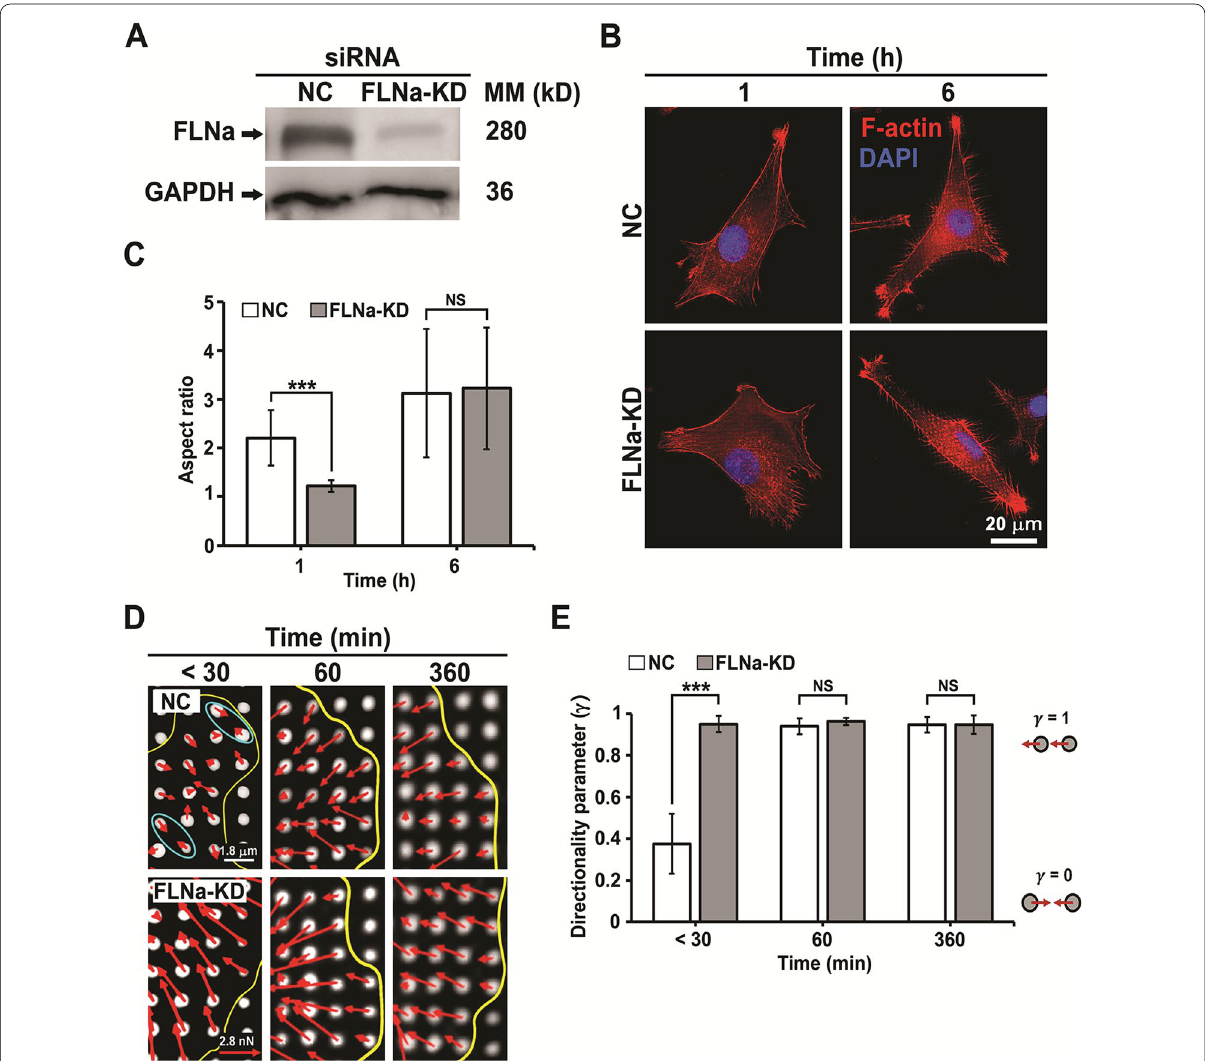
Fig. 2 Cell spreading and rigidity sensing ability of NC and FLNa-KD cells on fibronectin-coated pillars (diameter, 900 nm; height, 2 μm; and pillar center-to-center distance, 1.8 μm; bending stiffness k 24.2 nN/µm). A Western blot of FLNa. Control: GAPDH. B Fluorescence images of F-actin = (RP: red) and the nuclei (DAPI: blue) of cells on fibronectin-coated pillars at 1 and 6 h. C Aspect ratio of cells. (n 30 cells). D Deflection of pillars = in NC and FLNa-KD cells near the edge (approximately 34.5 µm 2 ) of cells at < 30, 60, and 360 min incubations. Local contractions in the NC cells are marked with cyan circles. The red arrows indicate pillar deflection. E Directionality parameters ( γ ) of the NC and FLNa-KD cells at < 30, 60, and 360 min incubations. γ is calculated as the sum of the force vectors of pillars divided by the sum of their magnitudes. γ is 1 when the force vectors of two neighboring pillars are parallel. γ is 0 when the force vectors of the pillars are locally contracted toward each other. Cell number n 6. Error bar = represents the mean standard deviation (SD). *** P < 0.001. Student’s t-test. NS Not ±